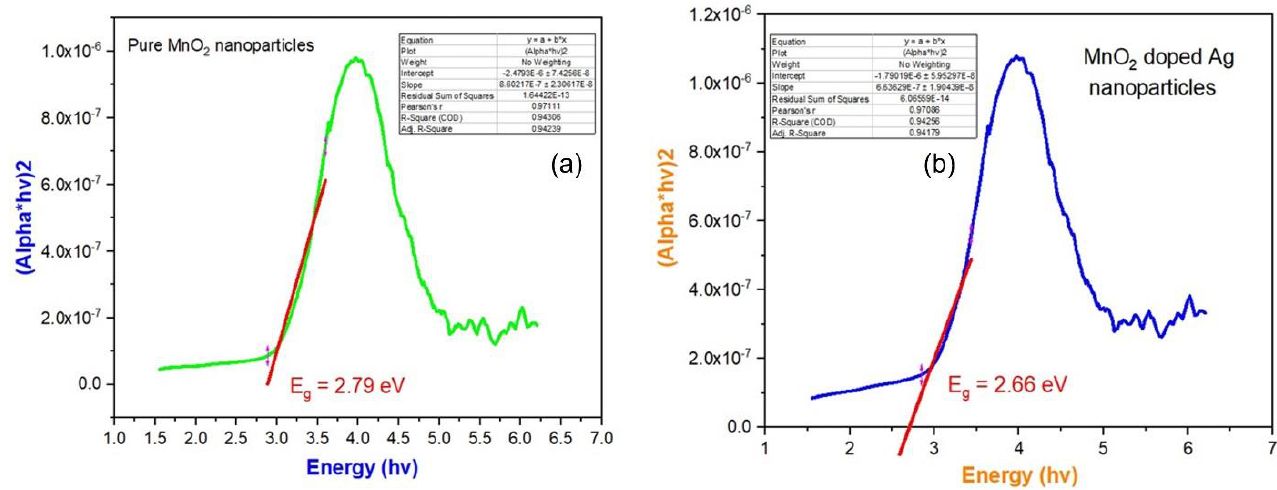
Figure 3. Tauc-plot relation spectrum of synthesised ( a ) pure MnO 2 and ( b ) MnO 2 doped with Ag nanoparticles.